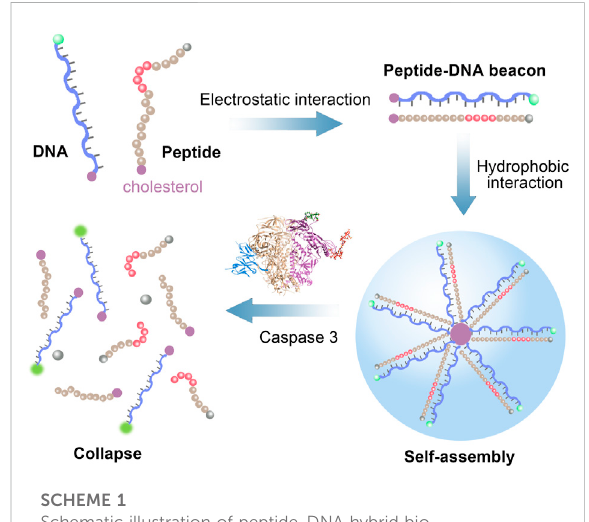
SCHEME 1 Schematic illustration of peptide-DNA hybrid bio- nanomicelles for caspase-3